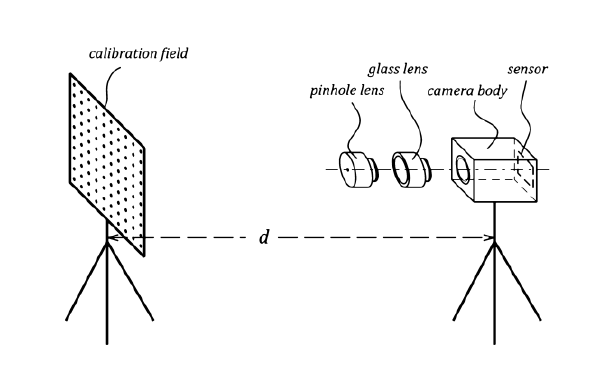
Figure 3. Arrangement of the proposed calibration